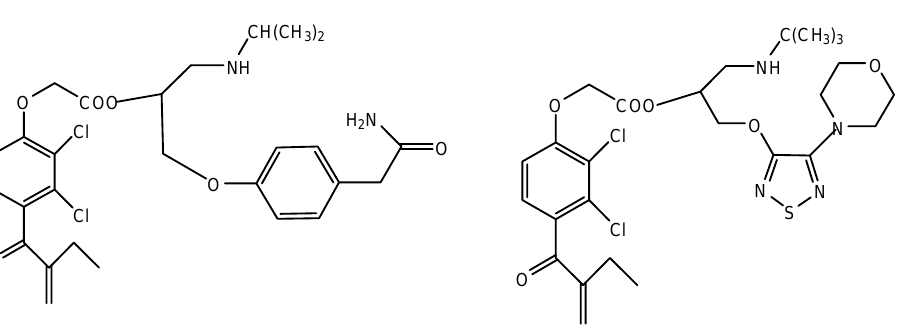
Figure 4. The structure of ECA-ATL and ECA-TML